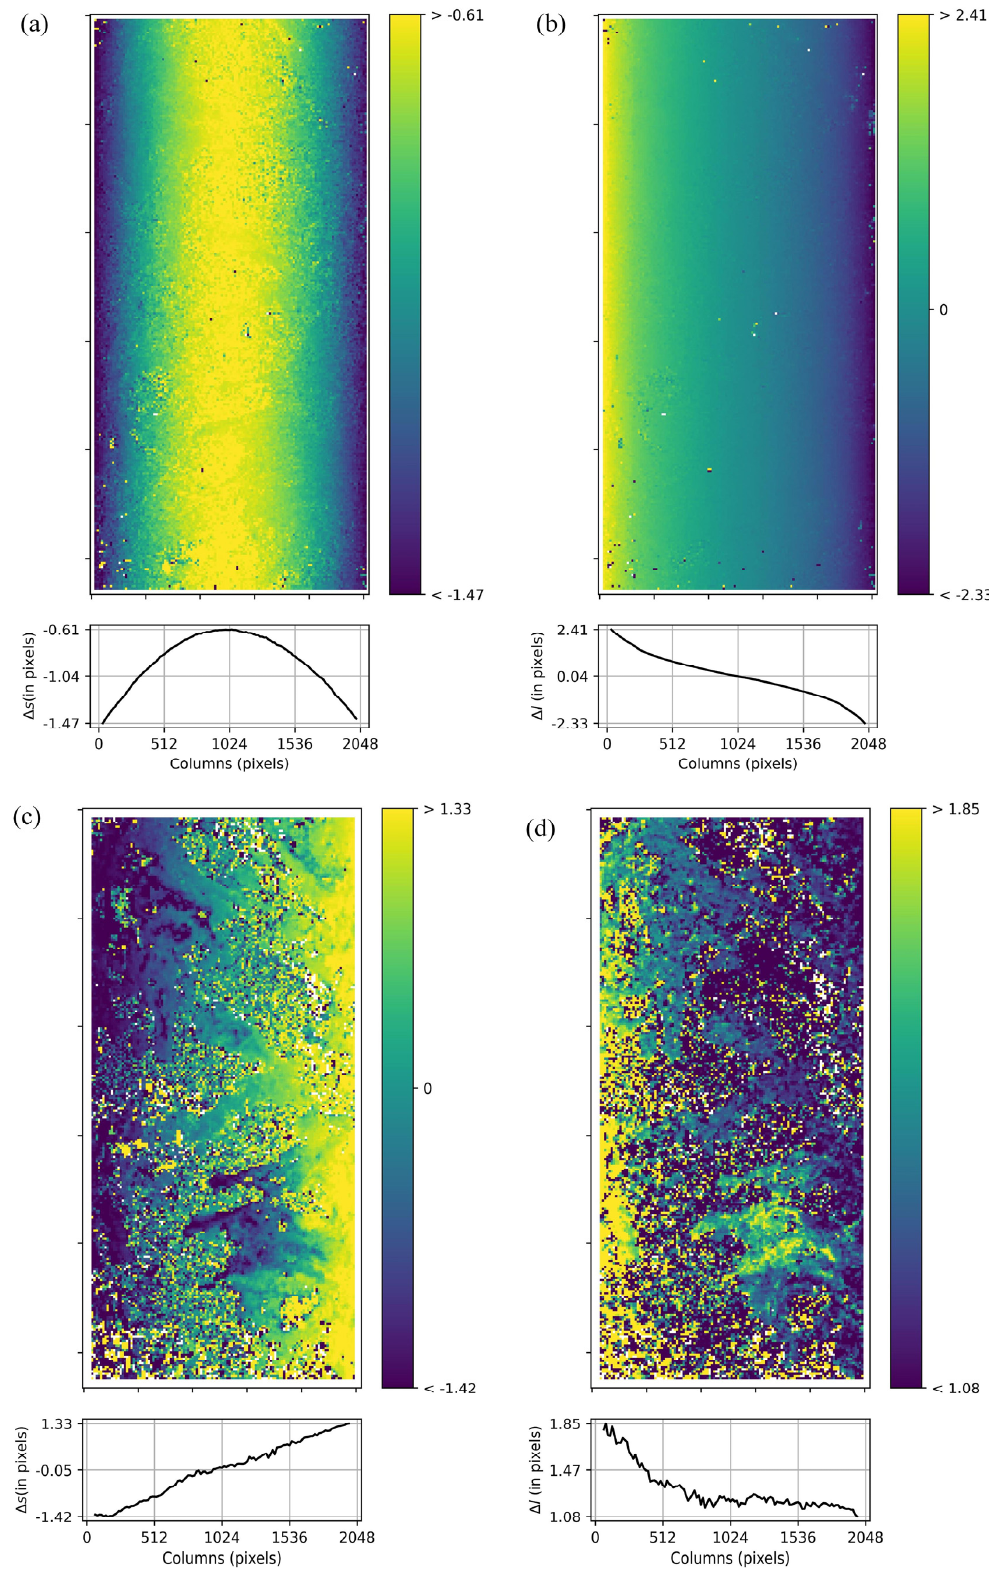
Figure 5. Band-to-band misregistration of FY-1D. ( a , b ) are the mis-registration in along-scan and along-track directions of B1B8. ( c , d ) are the misregistration in along-scan and along-track directions of B1B4.